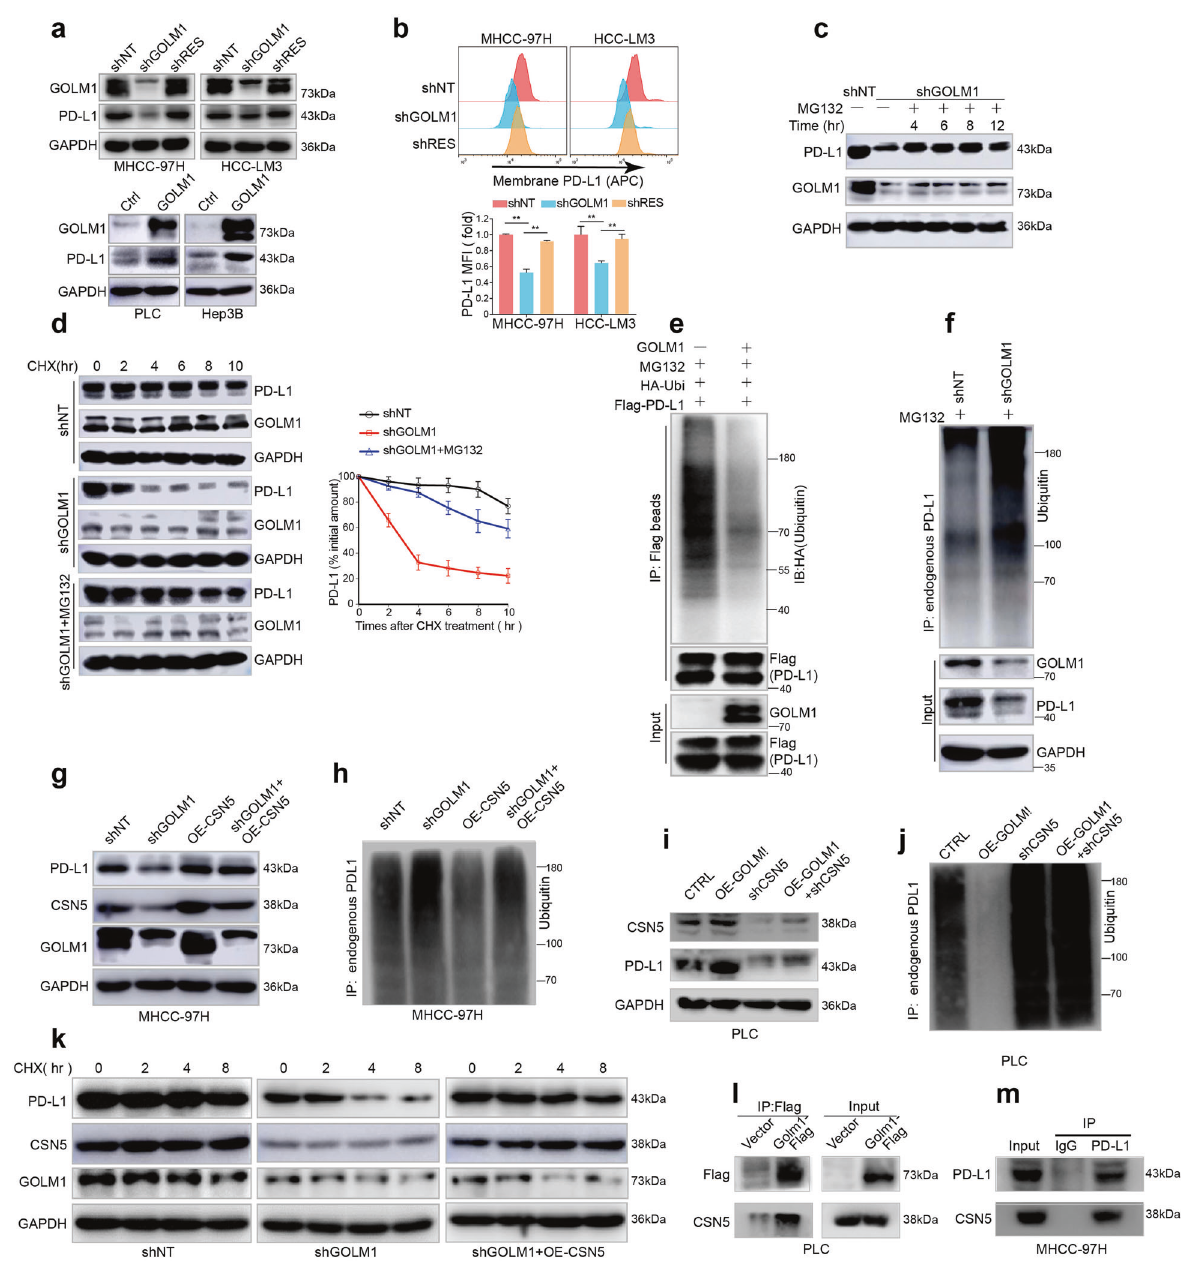
Fig. 3 GOLM1 upregulates PD-L1 expression via CSN5-mediated PD-L1 deubiquitination in HCC cells. a The GOLM1 expression levels and the corresponding PD-L1 levels in HCC cells detected by Western blot when GOLM1 was knocked down by shGOLM1 and then restored by shRES- GOLM1 in MHCC-97H and HCC-LM3 cells (top panel), and when GOLM1 was exogenously upregulated by transfection of GOLM1 FLAG in PLC and Hep3B cells (bottom panel). b Flow cytometric analyses of membrane PD-L1 expression in MHCC-97H and HCC-LM3 cells after downregulation and rescue of GOLM1 expression. The relative quanti fi cation is shown on the bottom panel. c Immunoblot showed that GOLM1-KD signi fi cantly decreased PD-L1 expression in MHCC-97H cells, which was alleviated by the proteasome inhibitor MG132 (10 μ M). d Protein stability assay showed that GOLM1-KD signi fi cantly accelerated the degradation of PD-L1 protein, which could be attenuated by MG132. HCC cells were treated with 20 μ g/mL cycloheximide (CHX) at indicated intervals and subjected to Western blot (left panel). The quanti fi cation is shown on the right panel. Ubiquitination assay of PD-L1 in HEK293T cells ( e ) and MHCC-97H-shGOLM1 cells ( f ) transfected with the indicated plasmids. Ubiquitinated PD-L1 was immunoprecipitated and subjected to Western blot analysis with an antibody against ubiquitin. Cells were treated with MG132 before ubiquitination analysis. Western blot analysis demonstrated that PD-L1 decrease ( g ) and ubiquitination ( h ) induced by GOLM1 knockdown were abolished by overexpression of CSN5. Western blot analysis demonstrated that upregulated expression ( i ) and decreased ubiquitination ( j ) of PD-L1 induced by GOLM1 overexpression was abolished by knockdown of CSN5. k Western blot analysis demonstrated that PD-L1 protein degradation induced by GOLM1 knockdown was abolished by overexpression of CSN5. l Co-IP determined the interaction of GOLM1 and CSN5 from PLC cells transfected with Flag-GOLM1. m The interaction of endogenous PD-L1 with CSN5 in MHCC-97H cells was validated by Co-IP